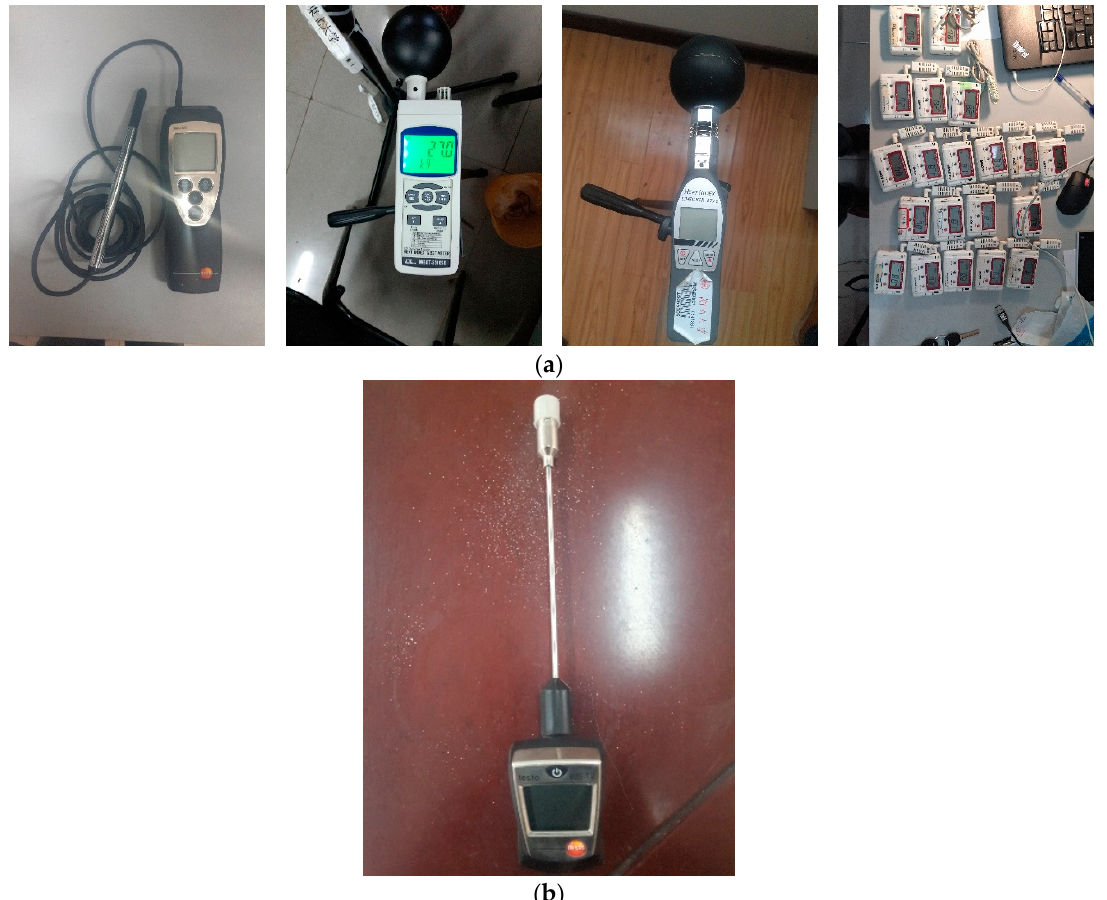
Figure 2. Instruments: ( a ) Physical instruments ( b ) Physiological instruments.